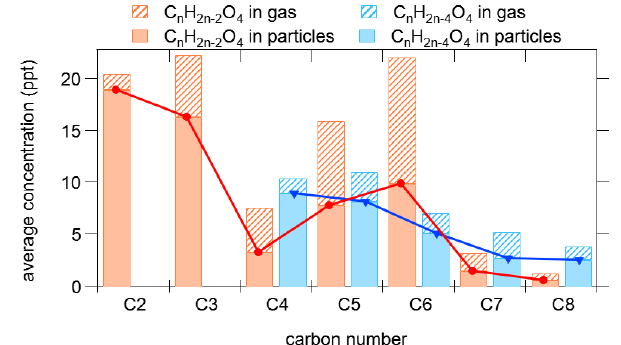
Figure 7. Average concentrations of compounds with the formulas of C n H 2 n − 2 O 4 and C n H 2 n − 4 O 4 .